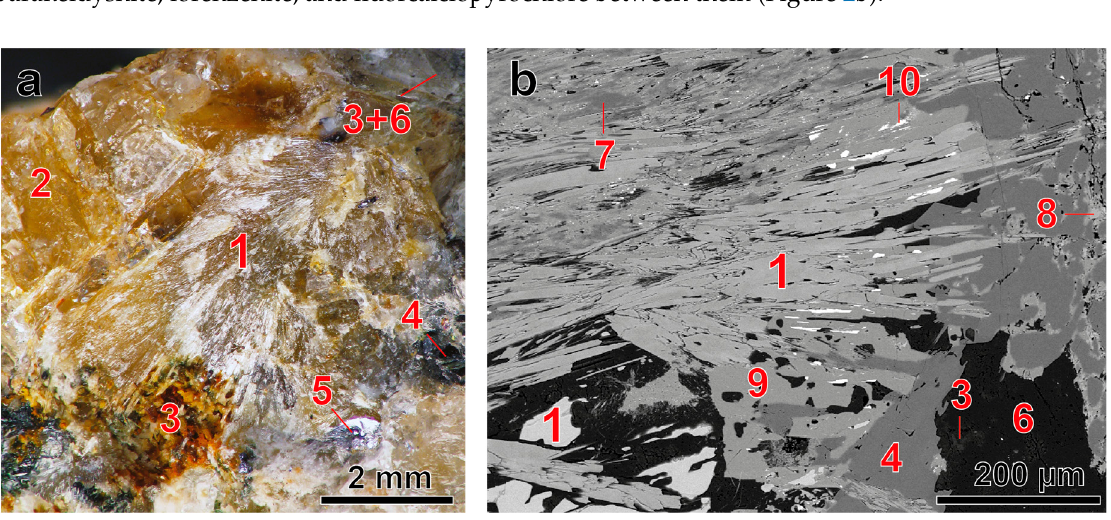
Figure 2. Radiated aggregate of chirvinskyite (1) in apatite segregation from albitized